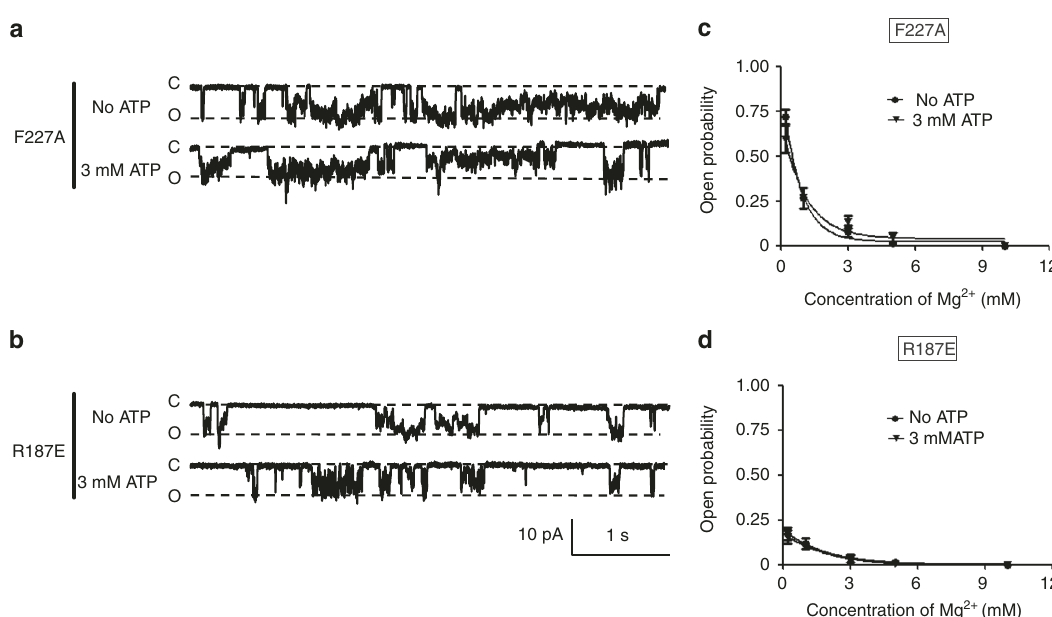
Fig. 5 Patch clamp analyses of ATP-binding site mutants of MgtE. a , b Representative current traces recorded at – 120 mV from a single membrane patch at 0.2 mM of Mg 2+ , with or without ATP, by the MgtE mutants F227A a and R187E b . c , d The open probabilities were determined at different [Mg 2+ ] in with or without ATP with the MgtE mutants F227A c and R187E d ( Bars represent ± SEM, n = 5 for each